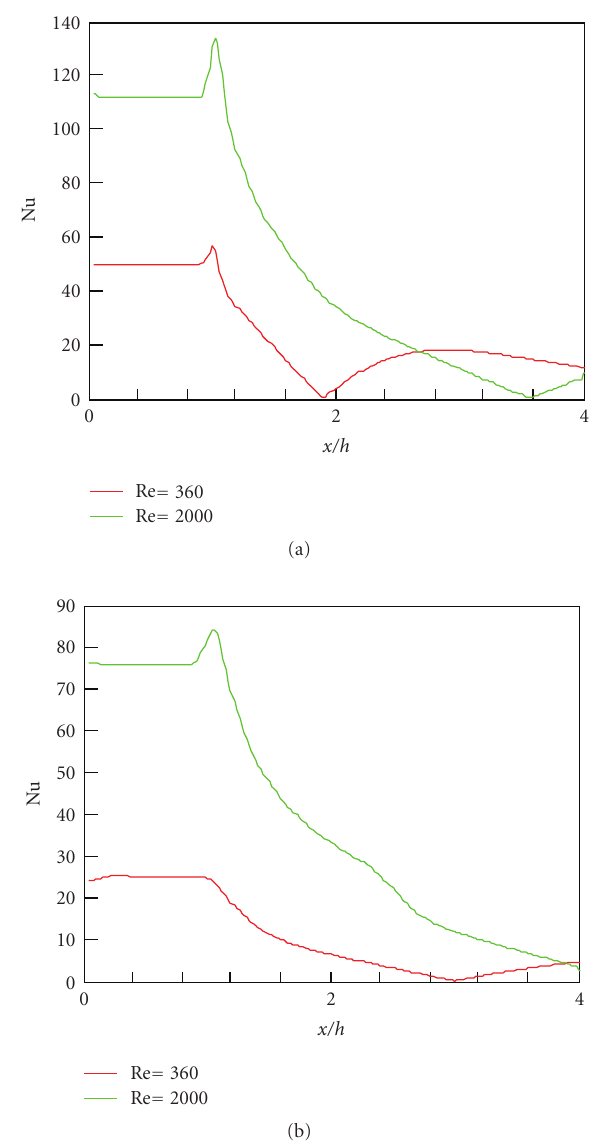
Figure 2: Local Nusselt Number on the Disk Surface, (a) h/D i = 0 . 05 and (b) h/D i = 0 .